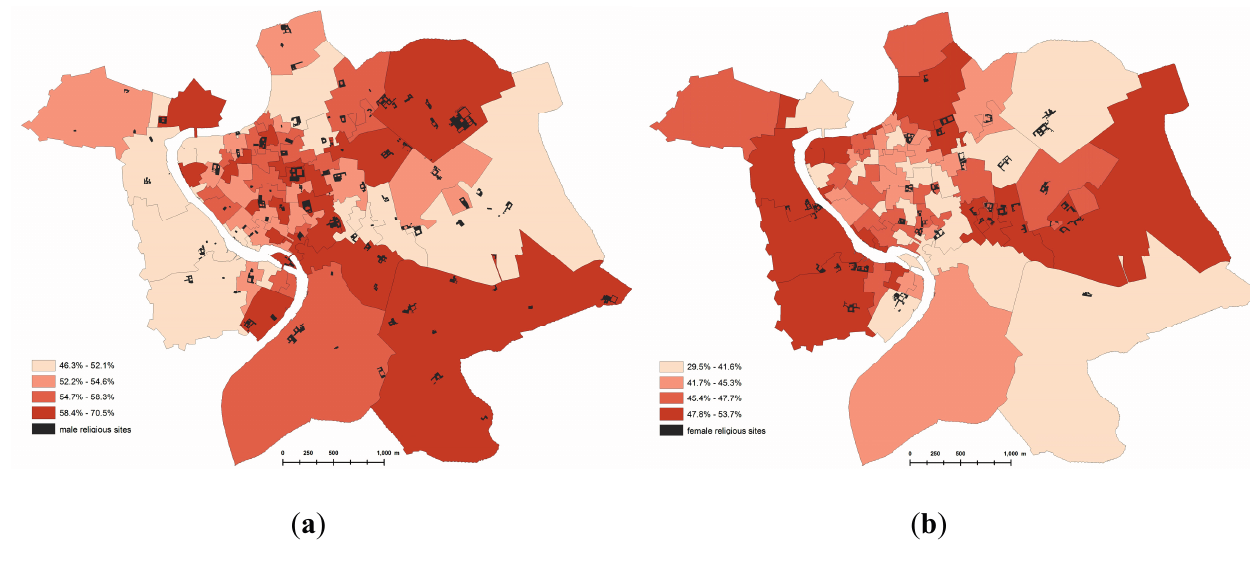
Figure 13. Incidence of males ( a ) and females ( b ) on the total population in the Rioni (districts) of Rome in the 18th